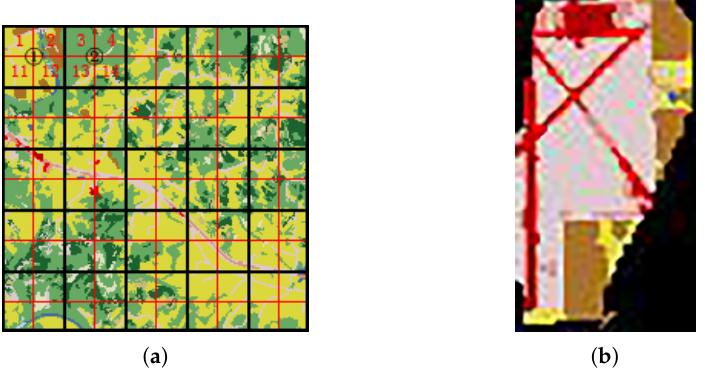
Figure 3. ( a ) Illustration of determining the signature of the candidate scene by combining the signatures in the base signature library; ( b ) Reference scene region of interest